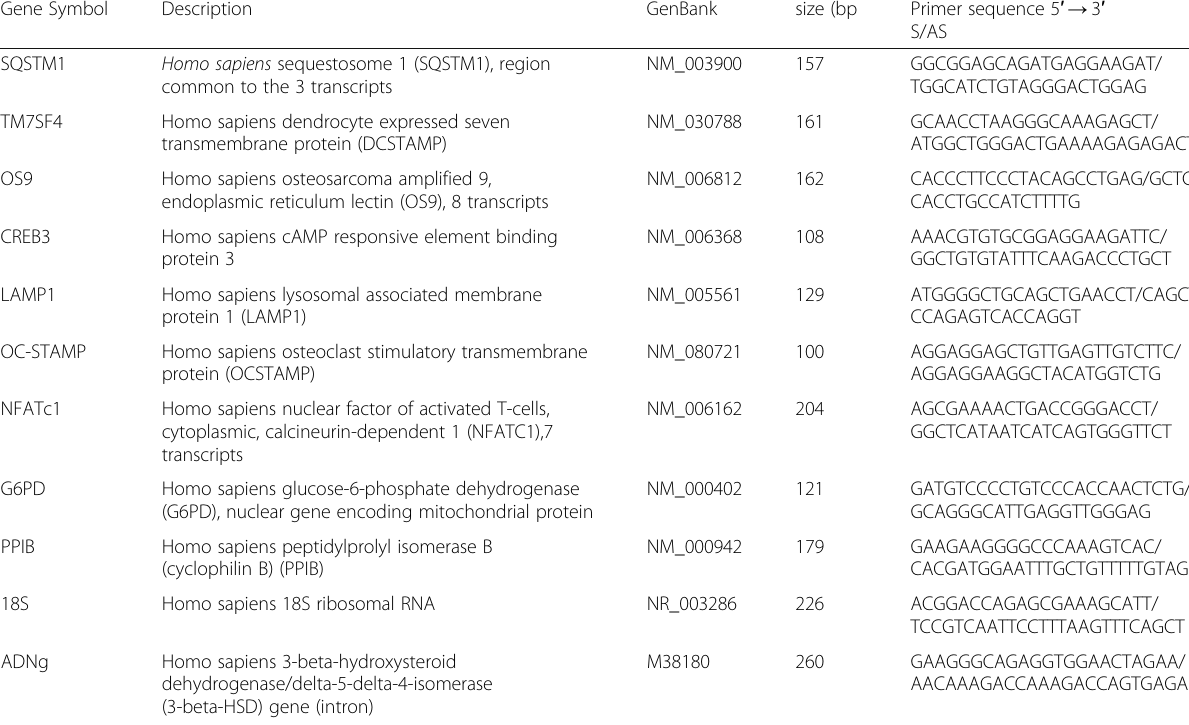
Table 2 Sequence primers and gene